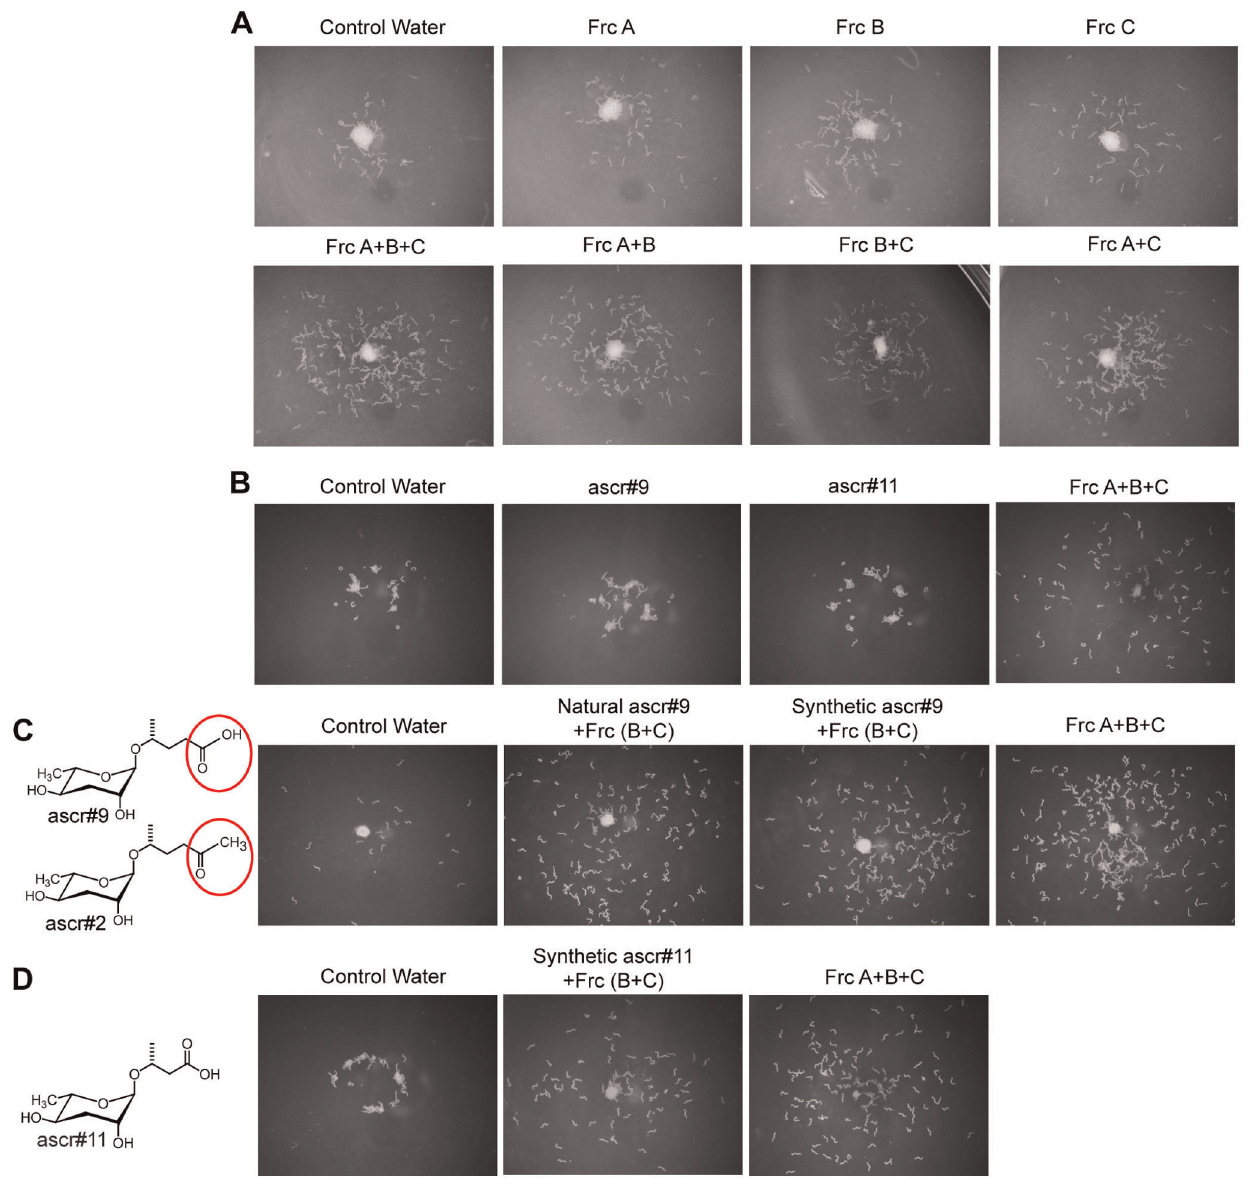
Figure 4. Activity guided fractionation of the S.feltiae dispersal pheromone. (A) Reverse phase (C18) chromatography of insect cadaver extract. The image represents two independent experiments. The estimated physiologically relevant concentration was used in the assays; Frc, fraction. (B) Testing physiologically relevant concentration of ascarosides found in Frc A (ascr # 9, 40.3 pmol/ m l and ascr # 11, 1.3 pmol/ m l). Image represents three experiments. (C) Ascr # 2 and ascr # 9 are structural analogs. Natural and synthetic ascr # 9 were tested in combination with fraction B and C. Image represents four experiments. (D) Structure of ascr # 11. It (1.3 pmol/ m l) is also sufficient to cause dispersal in combination with fractions B and C. Image represents three